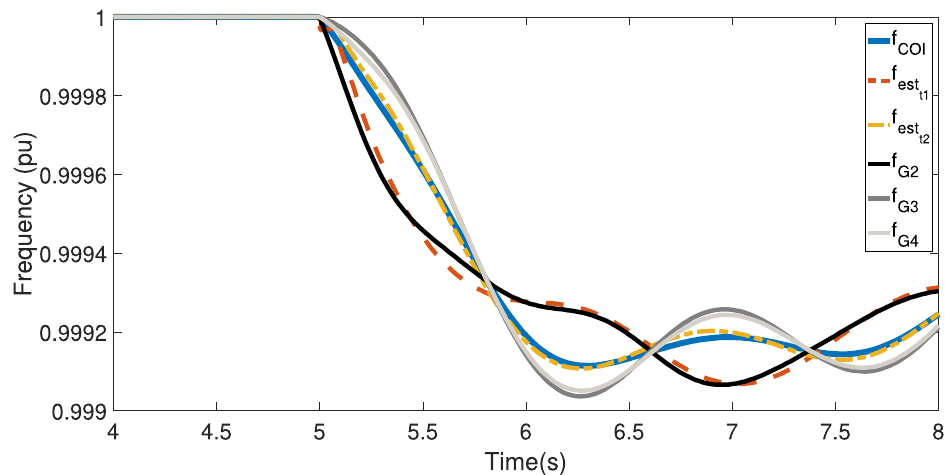
Figure 8. Validation studies—Frequency of Area 1.